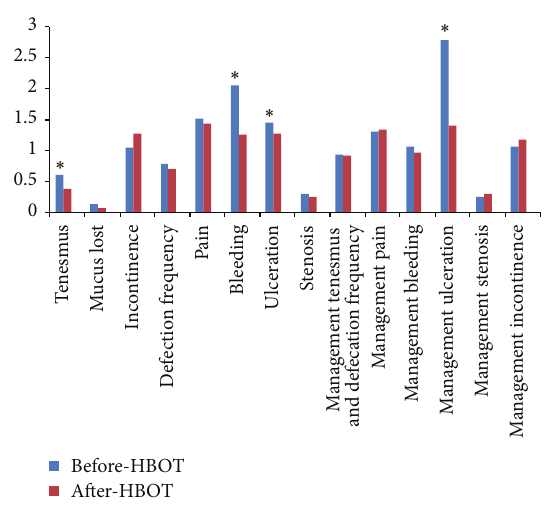
Figure 1: Median score for SOMA-LENT before HBOT versus SOMA-LENT after HBOT per patient and per symptom. ∗ 𝑃 <